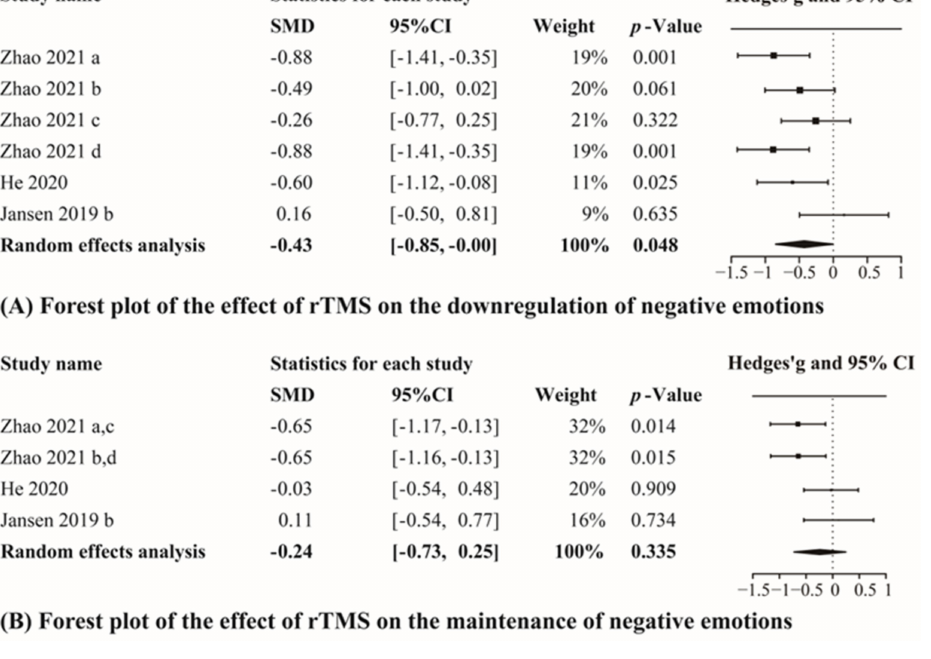
Figure 3. Results of the meta-analyses for rTMS studies. (a–d) Different effect sizes from the same study